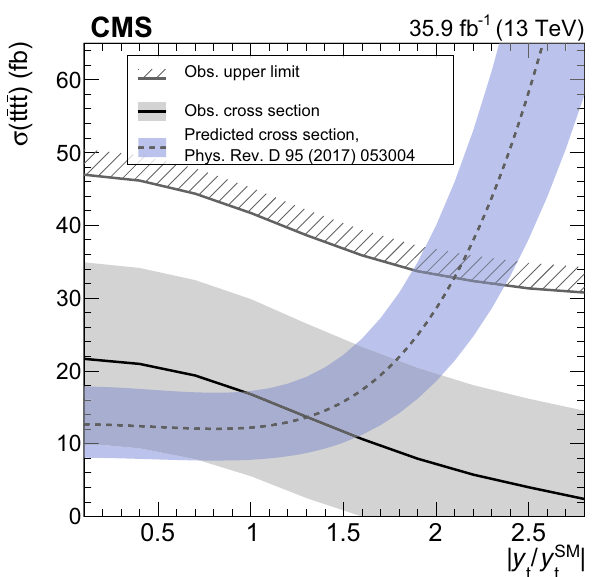
Fig. 5 The predicted SM value of σ( pp → tttt) [16], calculated at LO with an NLO/LO K -factor of 1.27, as a function of | y t / y SM t | (dashed line), compared with the observed value of σ( pp → tttt) (solid line), and with the observed 95% CL upper limit (hatched line)